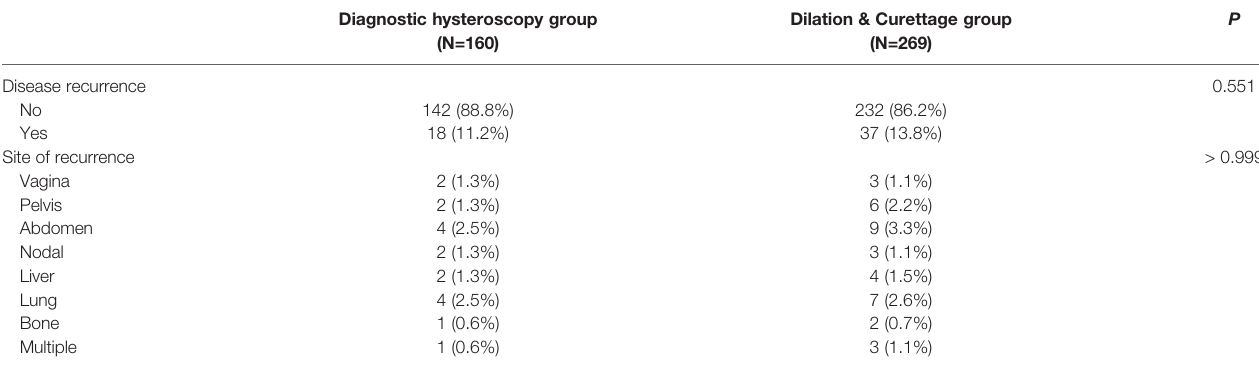
TABLE 2 | Patterns and rates of disease recurrence by diagnostic hysteroscopy vs. Dilation & Curettage.